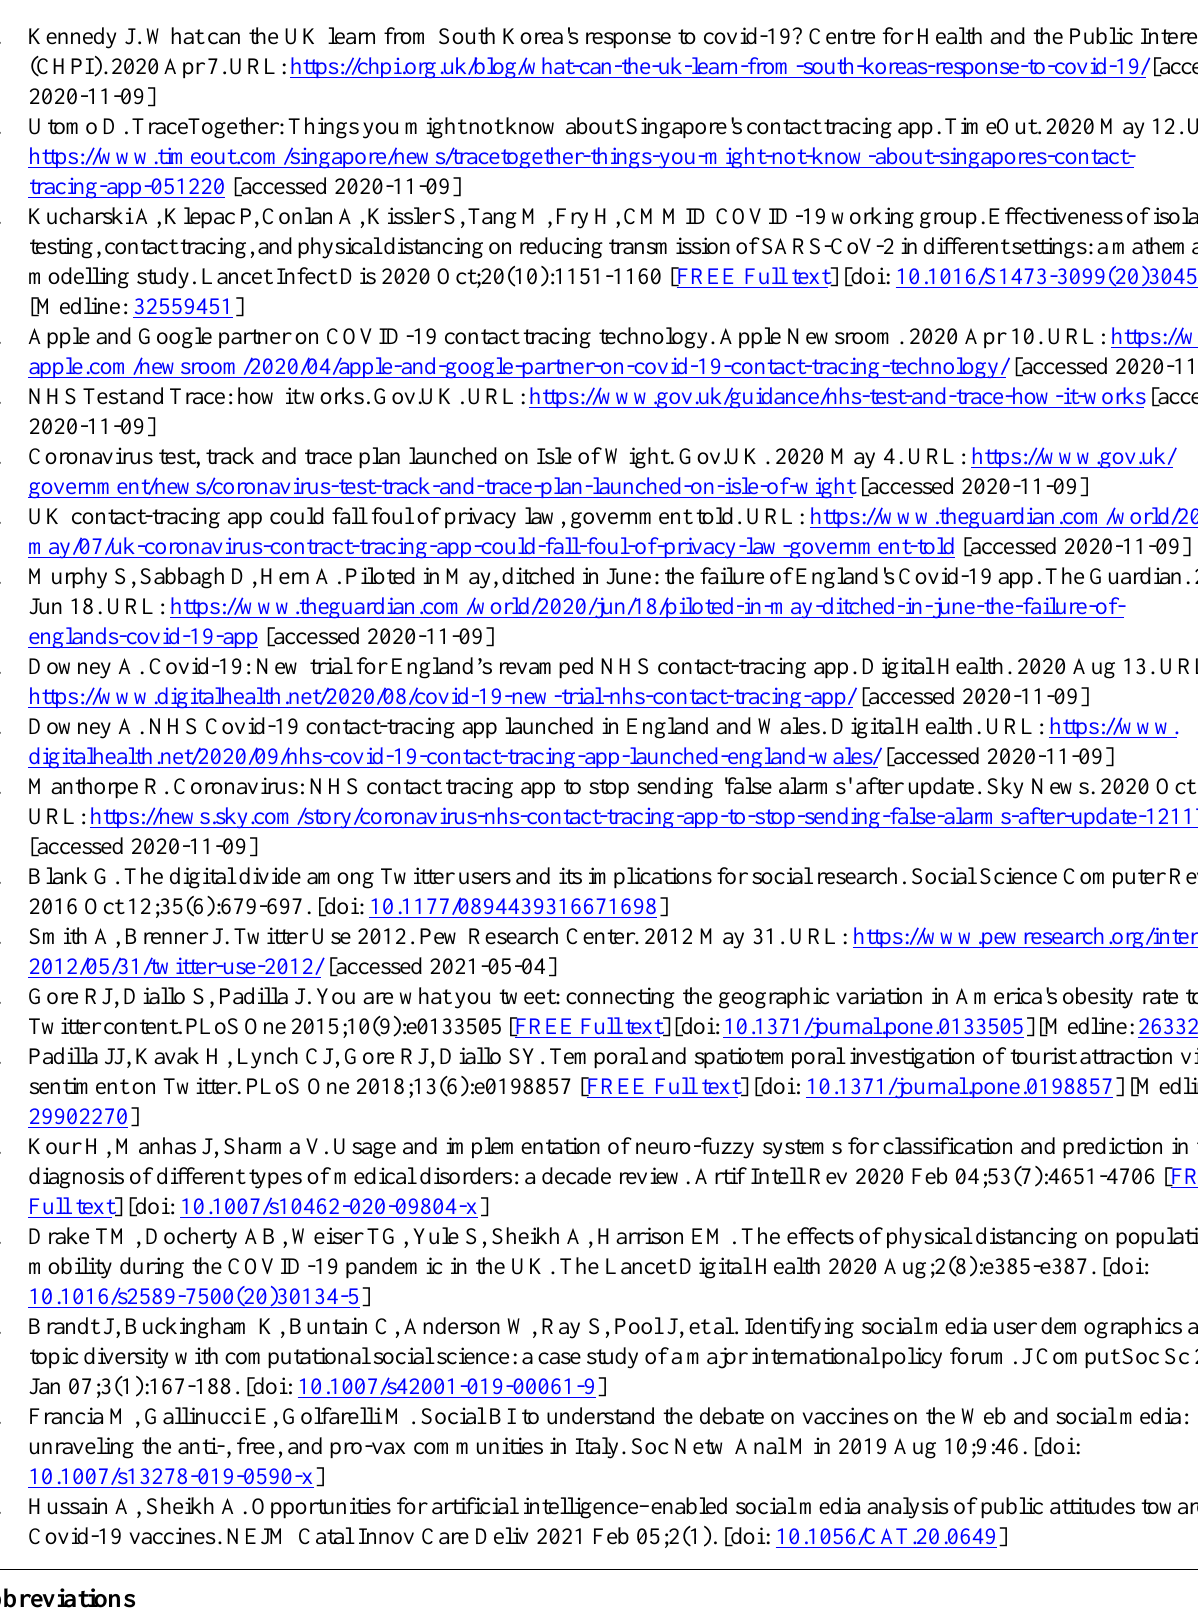
Abbreviations AI: artificial intelligence BERT: Bidirectional Encoder-Representations from Transformers DL: deep learning GDPR: General Data Protection Regulation VADER: Valence Aware Dictionary and Sentiment